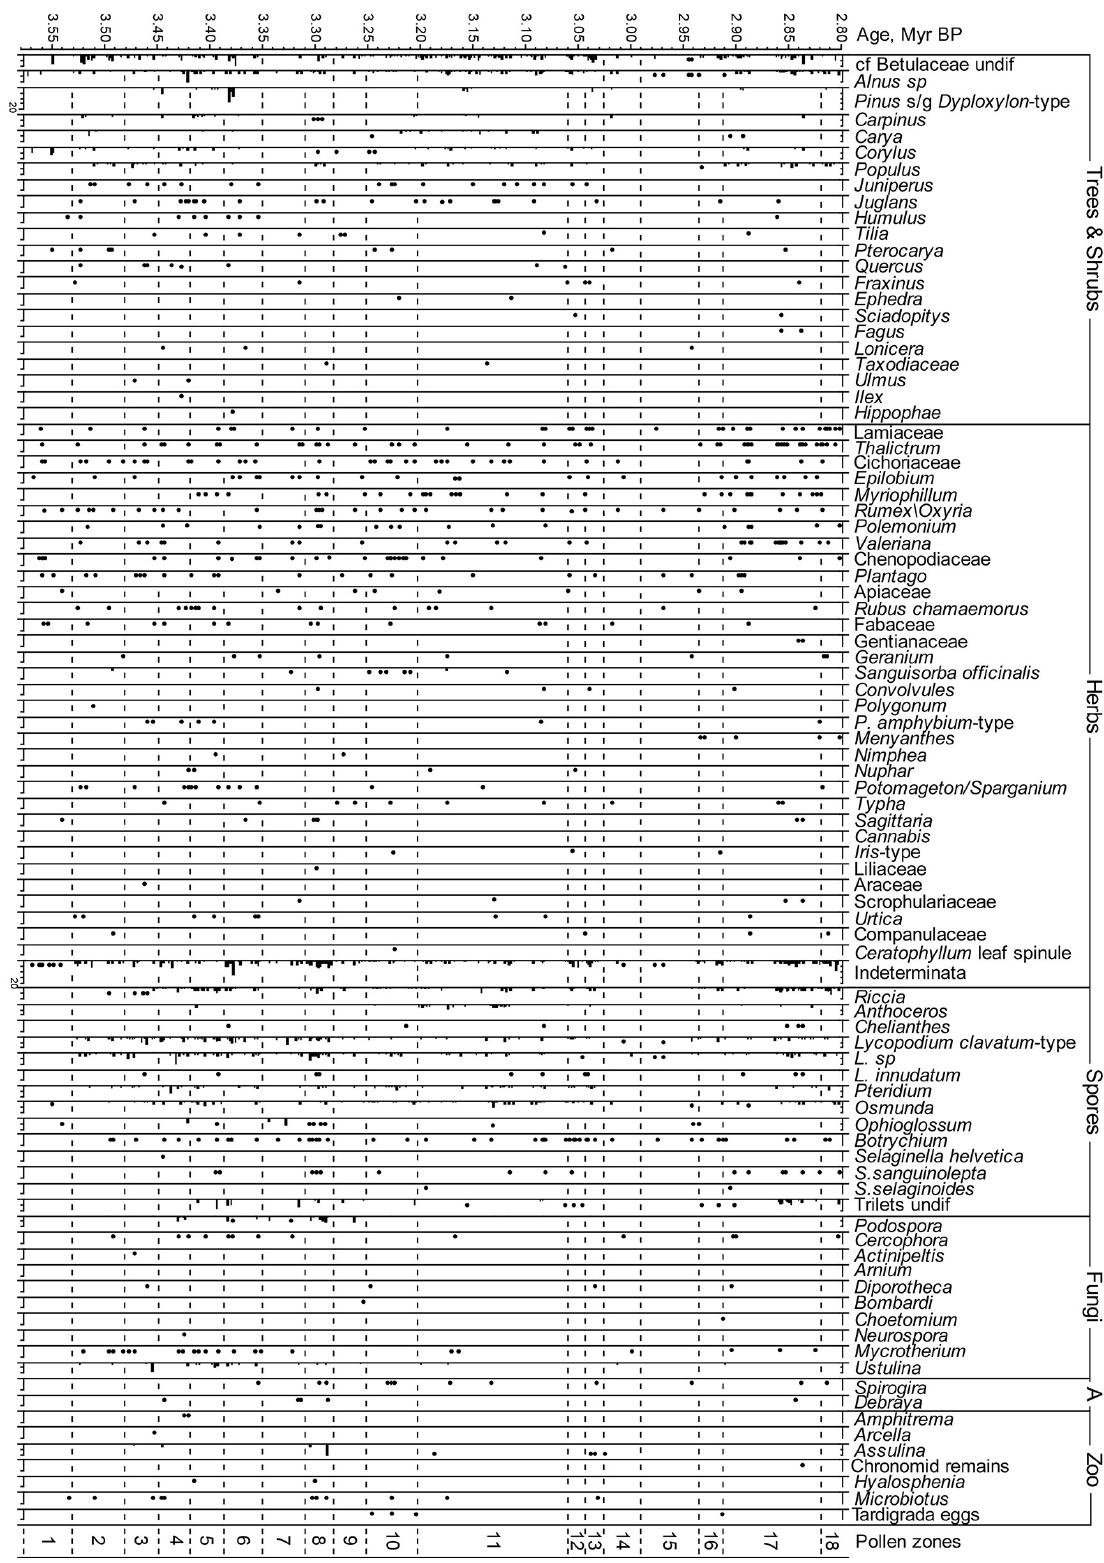
Figure 3b. Percentage pollen, spore, and non-pollen-palynomorph diagram. The minor pollen and spores types between ca. 3.58 and 2.8Myr